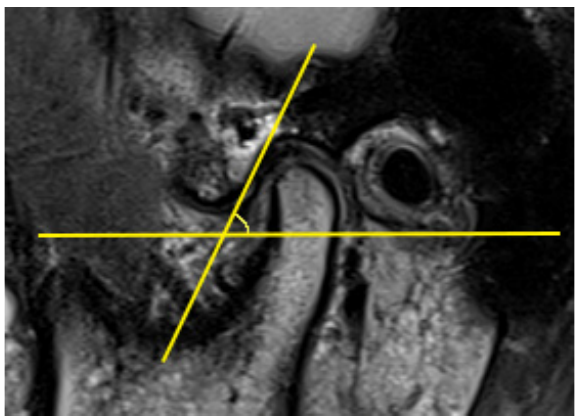
Figure 3. Representative images of the “best-fit line” method, the articular eminence inclination (AEI) defined as the angle between the tangent line drawn to the posterior slope of the articular eminence and the horizontal reference plane.